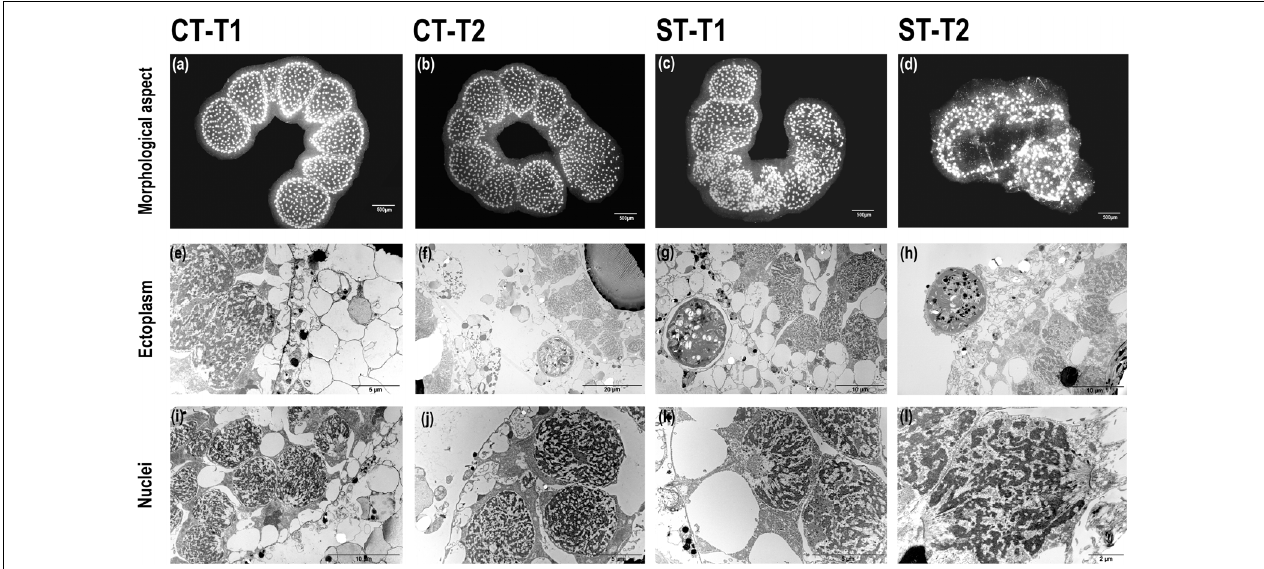
FIGURE 2 | Morphological and ultrastructural changes in control and heat-stressed Collozoum pelagicum . Observation of colonies overall morphological aspect at control T1 (a) and control T2 (b) at 21 ◦ C, thermal stress T1 at 25 ◦ C (c) and thermal stress T2 at 28 ◦ C (d) . Focus on the ultrastructure of ectoplasm at control T1 (e) , control T2 (f) , thermal stress T1 (g), and thermal stress T2 (h) . Focus on the nuclei ultrastructure at control T1 (i) and control T2 (j) , thermal stress T1 (k) , and thermal stress T2 (l) arrows.